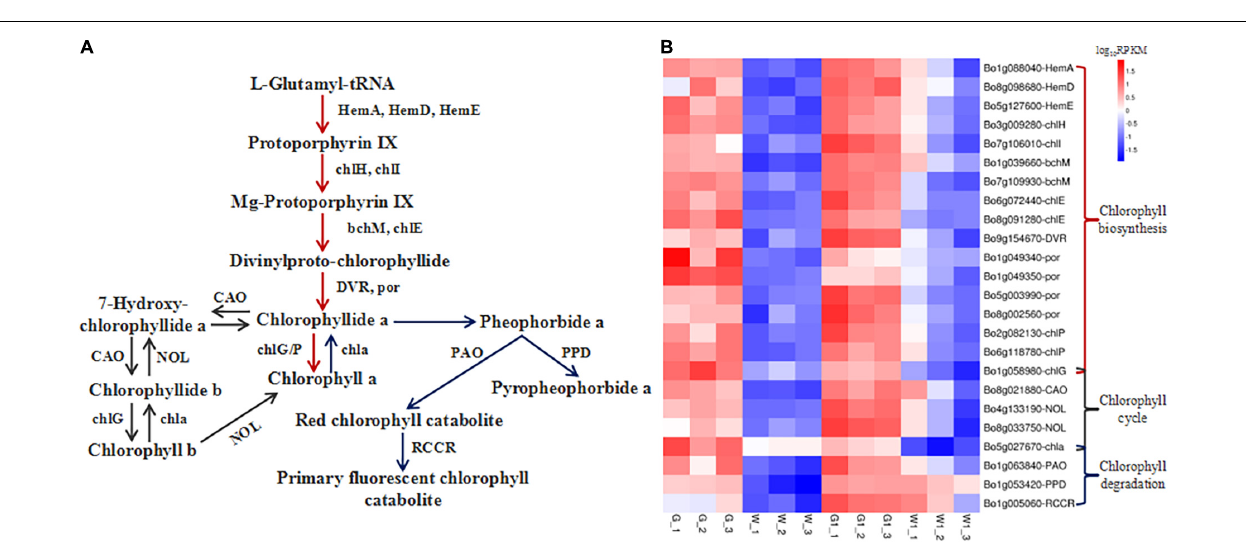
FIGURE 5 | Genes encoding enzymes involved in chlorophyll metabolism are differentially expressed in green vs. white kale leaf tissues. (A) Diagrammatic representation of the chlorophyll metabolism pathway involving the DEGs in G vs. W and G1 vs. W1. (B) Heatmap of the expression patterns of DEGs involved in chlorophyll metabolism in the four samples. Red and blue tiles indicate higher and lower FPKM values,